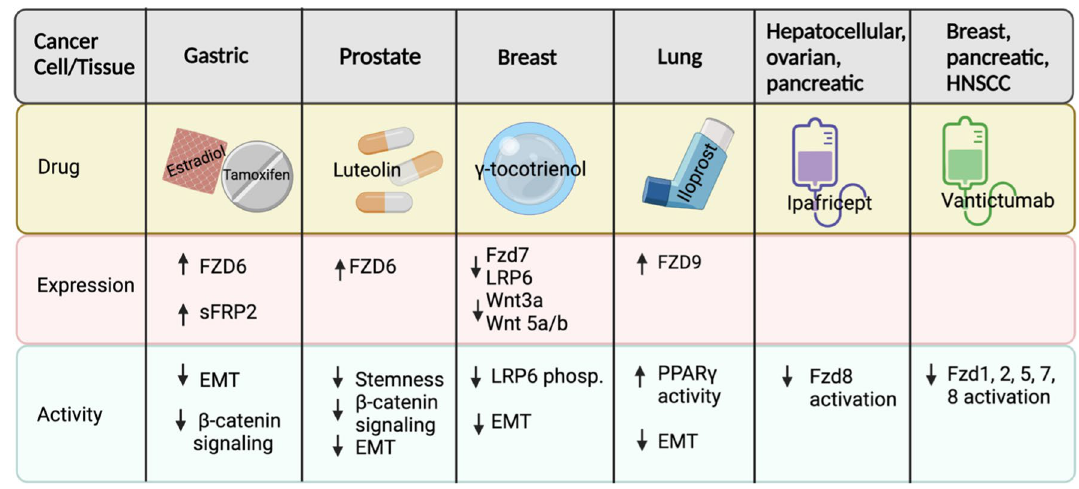
Table 2 Drugs with effects on Frizzleds in cancer cell lines or